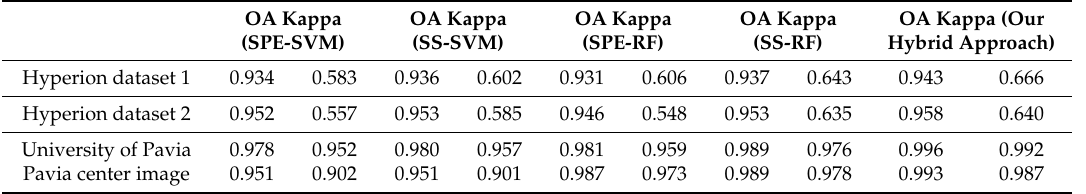
Table 5. Accuracy assessment for impervious surface estimation using different algorithm.